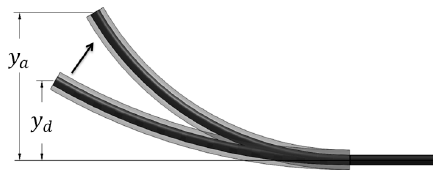
y ) and activated ( d